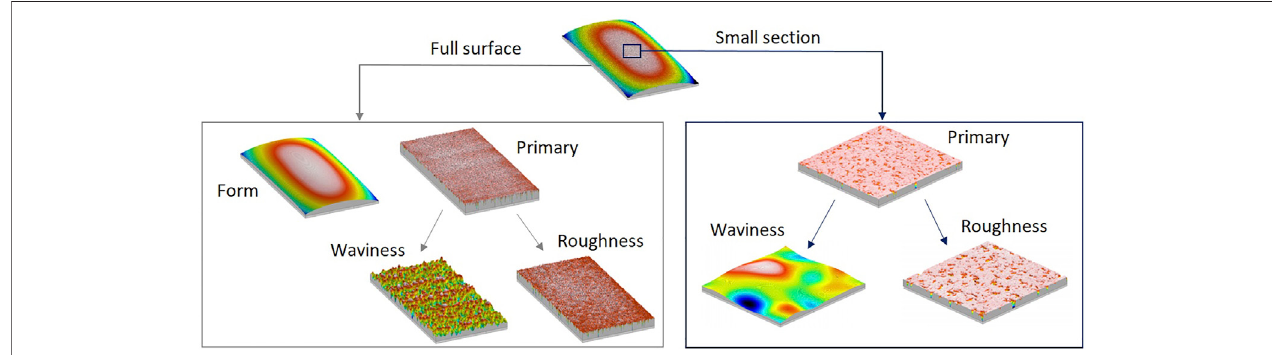
FIGURE 4 | Sample texture measurement — full surface and small section measurement. Full surface measurements provide essential information about the geometricalformofthesample.Smallsectionmeasurementshaveahighermeasuredpointdensity,thusprovidingmoredetailsaboutthesurfaces,e.g.,asperityheight, dimple size, pileup, and polished surface area. In both approaches, all surface parameters were calculated for the primary surface and for the fi ltered roughness pro fi les to evaluate the changes in the parameter